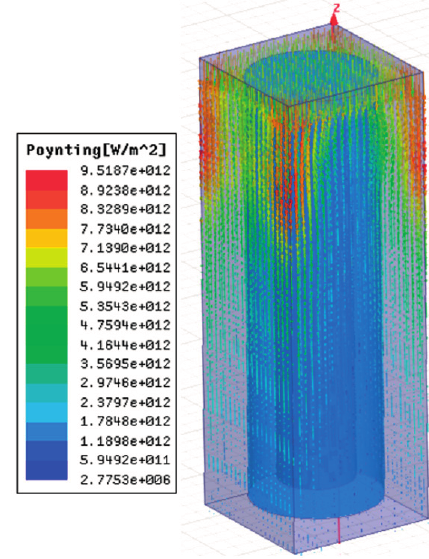
Figure 5. The energy field of the unit cell with core-shell nanowire